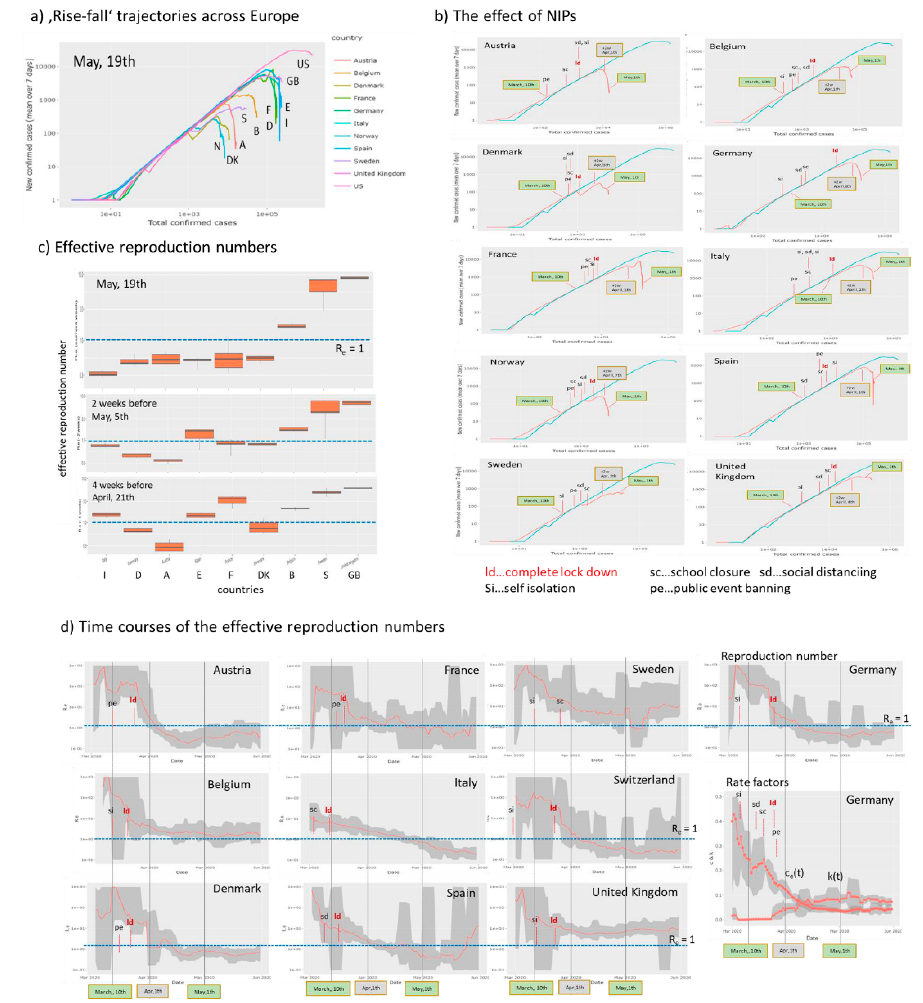
Figure 7. The effect of Non-Pharmaceutical Interventions across ten European countries selected in analogy with [12]. The trajectory of US is shown for comparison. ( a ) Rise-fall trajectories of selected countries mostly decay thus indicating marked decrease of epidemic in most cases. ( b ) Country-by-country plots of the rise-fall trajectories together with marks assigning the NIPs (dates and assignments were taken from [12]) show that the trajectories turn downwards about two weeks after lockdown in most cases (the grey box refers to the ‘two weeks after the last measure’ date). Exceptions are Sweden (no complete lockdown) and United Kingdom. The two green boxes indicate the data obtained at March 10 th (mostly before measures) and May 1th. ( c ) The effective reproduction numbers are still clearly above the critical value of R e =1 for Sweden and Great Britain. Italy and France show the strongest decay of Re over the last 4 weeks. ( d ) Courses of the effective reproduction number as a function of time indicate a marked drop of Re(t) immediately after the lock down in most countries. Also the first measure taken is indicated. For Germany, all five measures were indicated together with the courses of the rate factors.